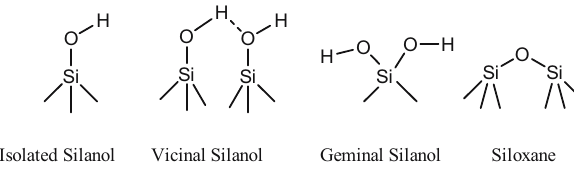
Figure 1: Types of silanol and siloxane on the surface of